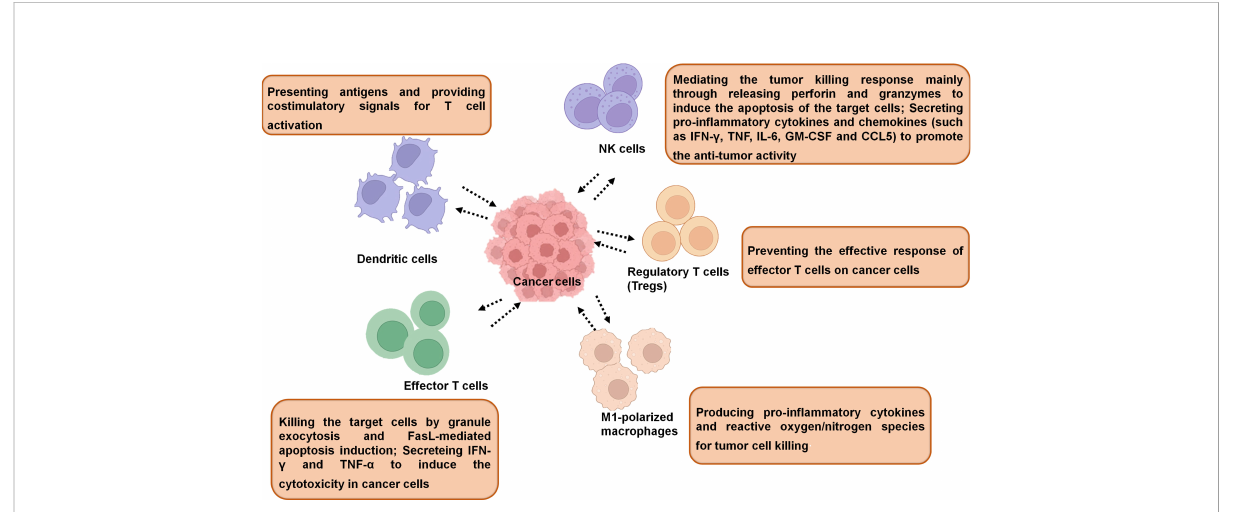
FIGURE 1 The immune cells in TME. The tumor-associated immune cells can be divided into two types: tumor-antagonizing and tumor-promoting immune